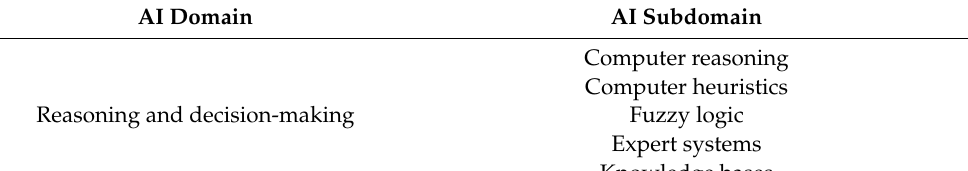
Table 1. The taxonomy of